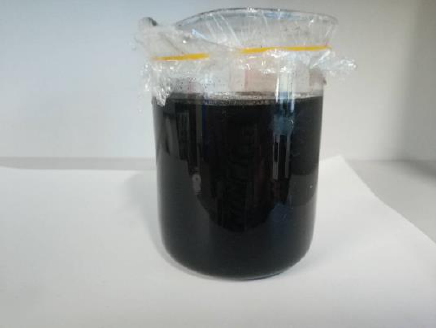
Figure 2. The dispersed carbon nanoparticles in the scale-forming solution.